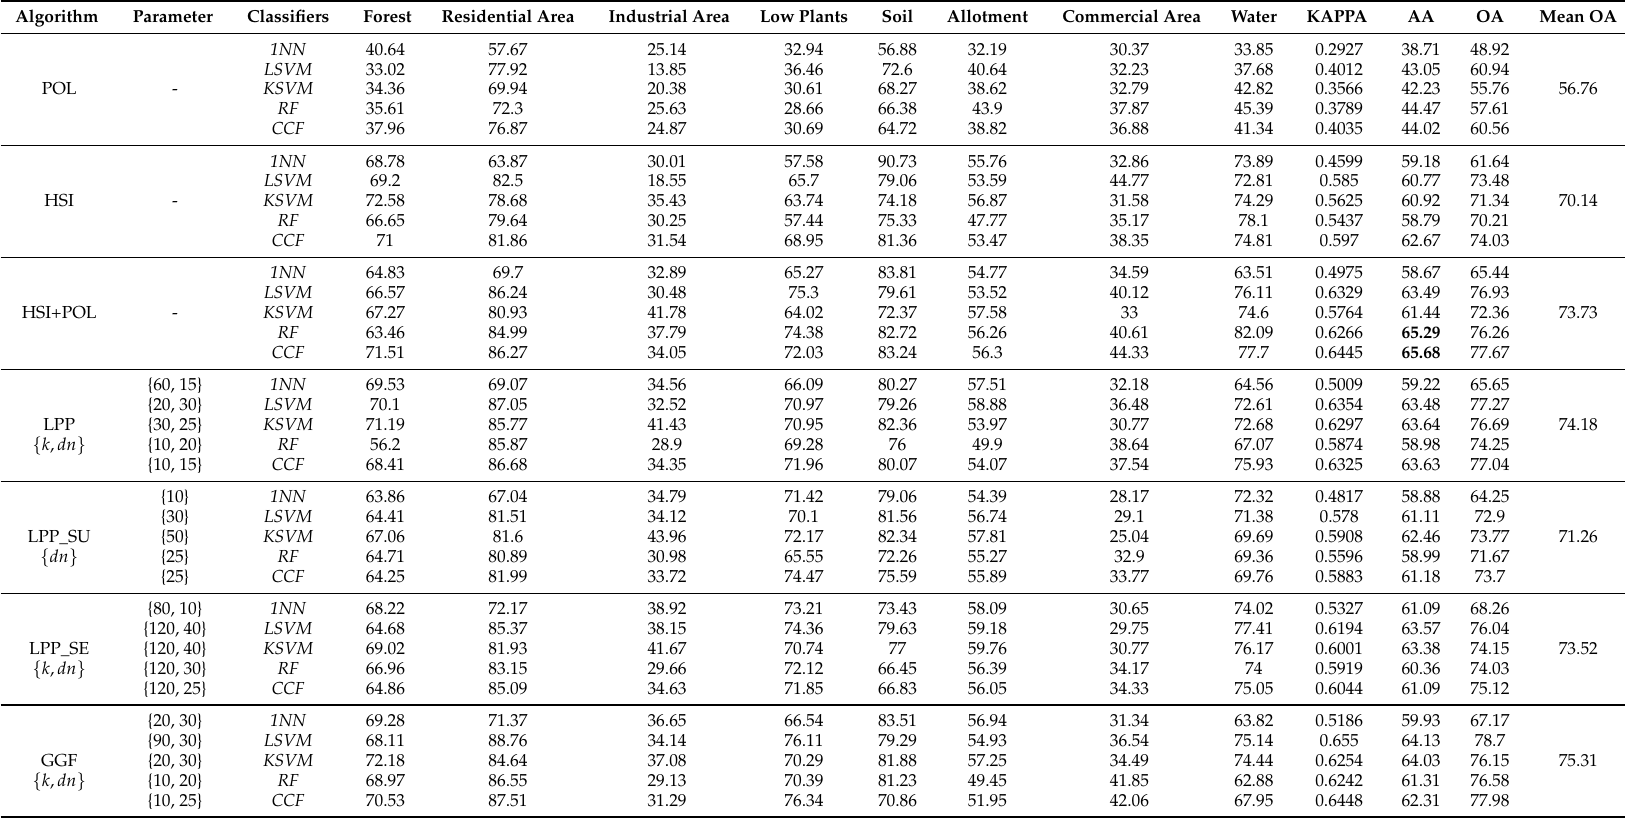
Table 5. Quantitative performance comparison on the Berlin data, in terms of class-specific accuracy, kappa coefficient, average accuracy, overall accuracy, and mean overall accuracy. The mean overall accuracy is calculated based on the overall accuracies achieved by the five classifiers. The listed indications are achieved after hyperparameter tunning. The hyperparameters of each algorithm are listed under the name of the algorithm and their values are listed in the table. The kappa coefficient, average accuracy, and the overall accuracy that larger than 0.66, 65%, and 79% are marked in bold. And the three highest mean overall accuracies are also marked in